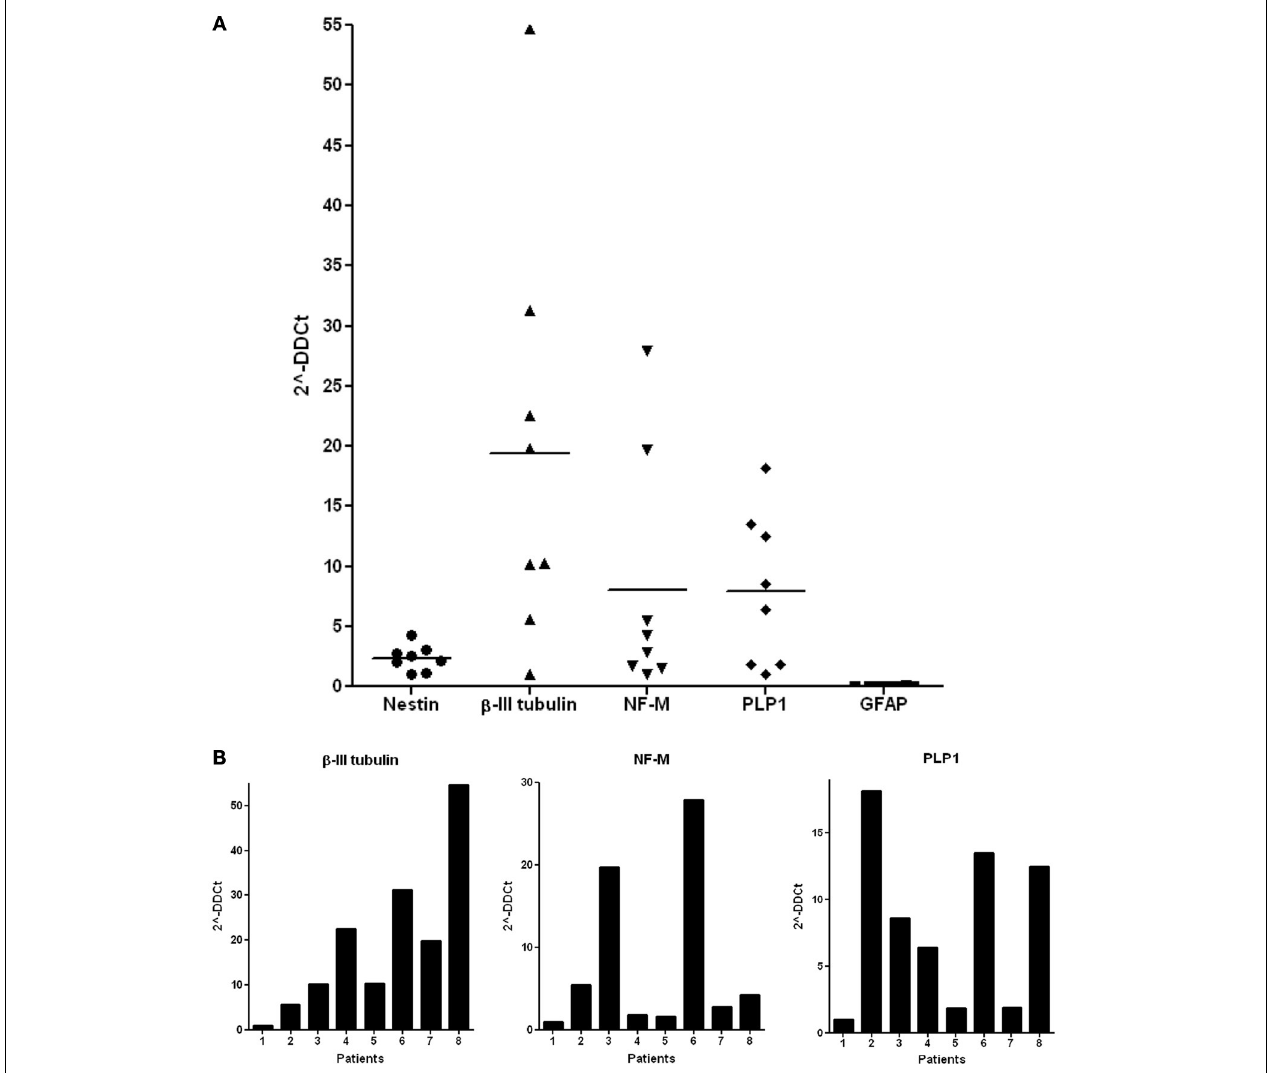
FIGURE 4 | Expression of neuronal markers in the ADH-DPSC fibroblastic populations. (A) The mean of qPCR results for Nestin, β -III tubulin, NF-M, PLP1, and GFAP expressions on ADH-DPSCs with fibroblastic morphology from 6 patients. (B) Analysis of qPCR results according to each donor.